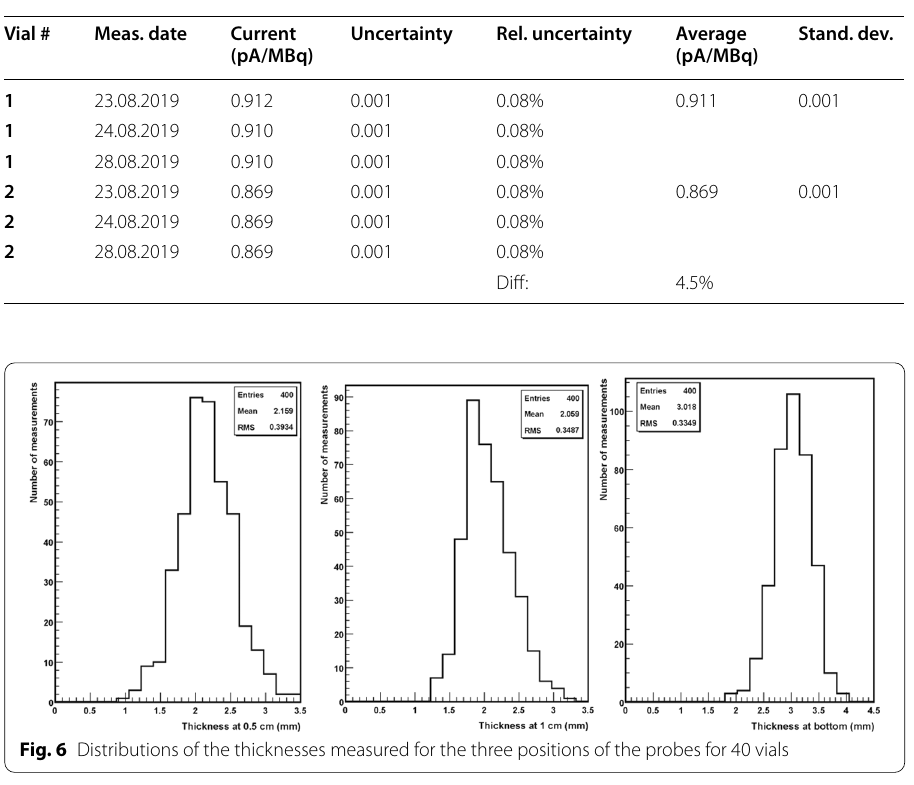
Table 2 Normalized current produced in the ionization chamber for two penicillin vials filled with the same solution of 161 Tb